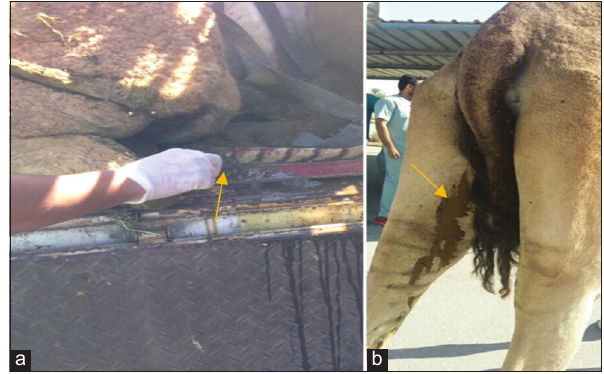
a Figure-1: Clinical picture of Johne’s disease. (a) Rectal scrapings in a camel suffered from chronic diarrhea. (b) Diarrhea on a camel hind quarter.